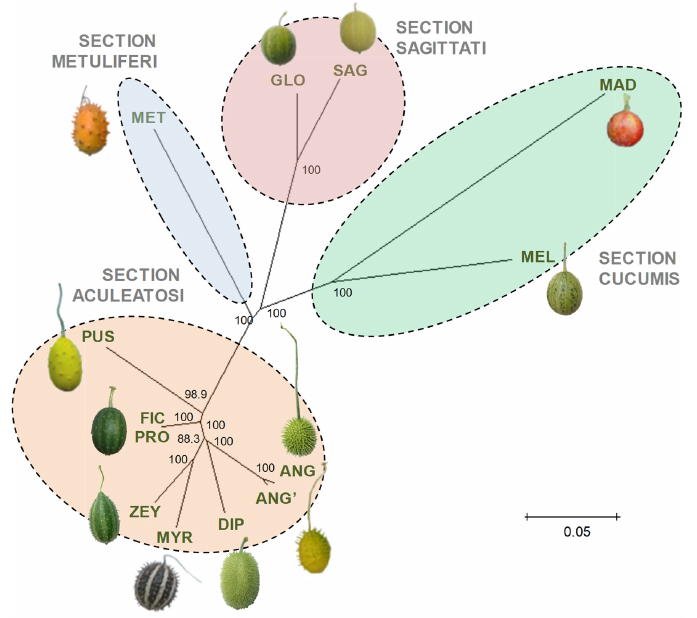
Figure 9. NJ phylogenetic tree based on the genetic distances among Cucumis spp. accessions estimated from GBS data. Bootstrap values with 1000 replicates expressed as a percentage (%) are shown at the nodal branches.